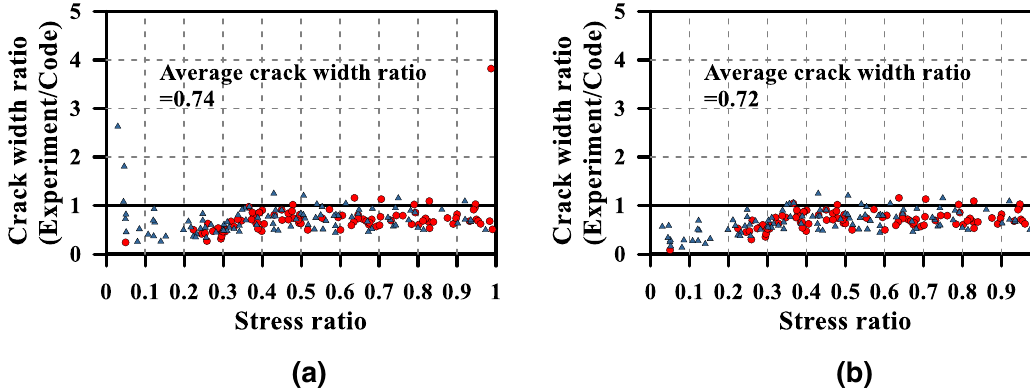
Fig. 19 Ratio of the measured and calculated maximum flexural crack widths using Eq. (26) . a Using Eq. (25) and b Using f s = 0.4fy when f s \ f y instead of Eq. (25) (Circle points are the specimens in this work; triangle points are the specimens in the references (Chiu et al. 2014, 2016)).